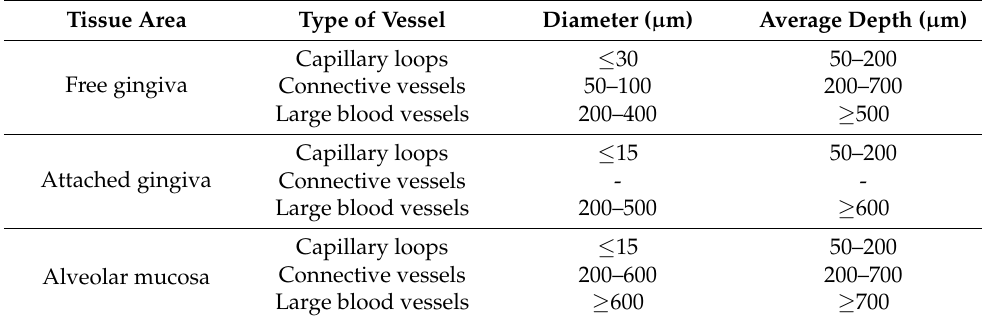
Table 1. An outline of the vessels found within gingival tissue adapted from previous literature [24]. Tissue